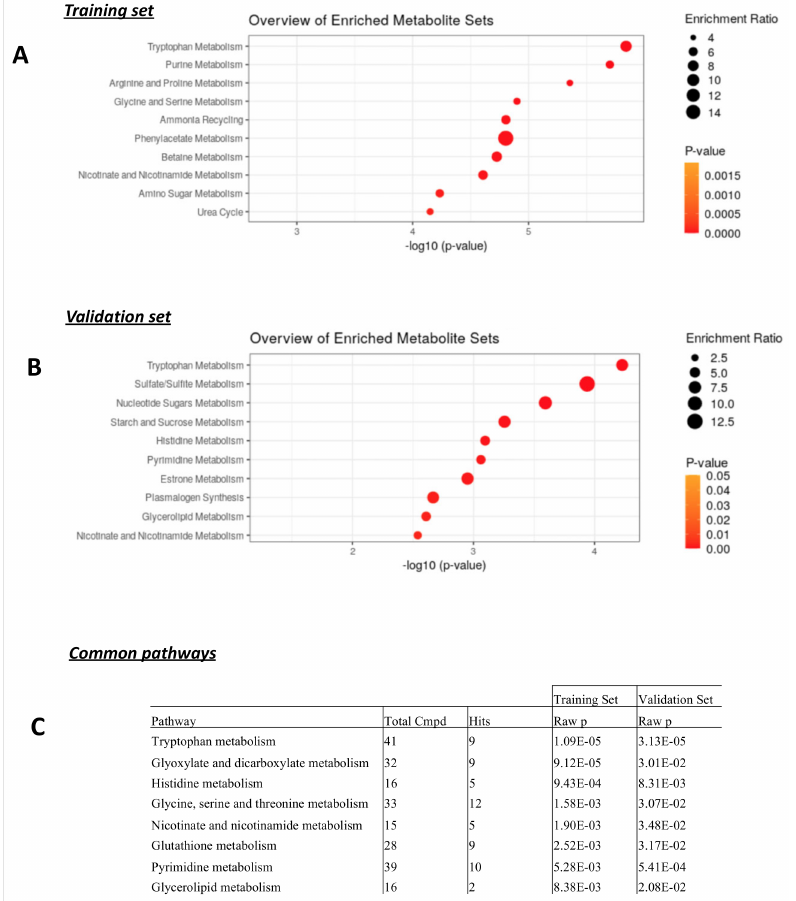
Figure 4. Metabolite set enrichment analyses and metabolic pathway analyses highlighted the tryptophan metabolism. The top 10 enriched metabolite sets in the analyses performed on the training set and the validation set are shown in ( A , B ), respectively. Metabolic pathway analyses were also performed on both sets and the top 7 common significant metabolic pathways are illustrated in ( C ). More details are provided in Table